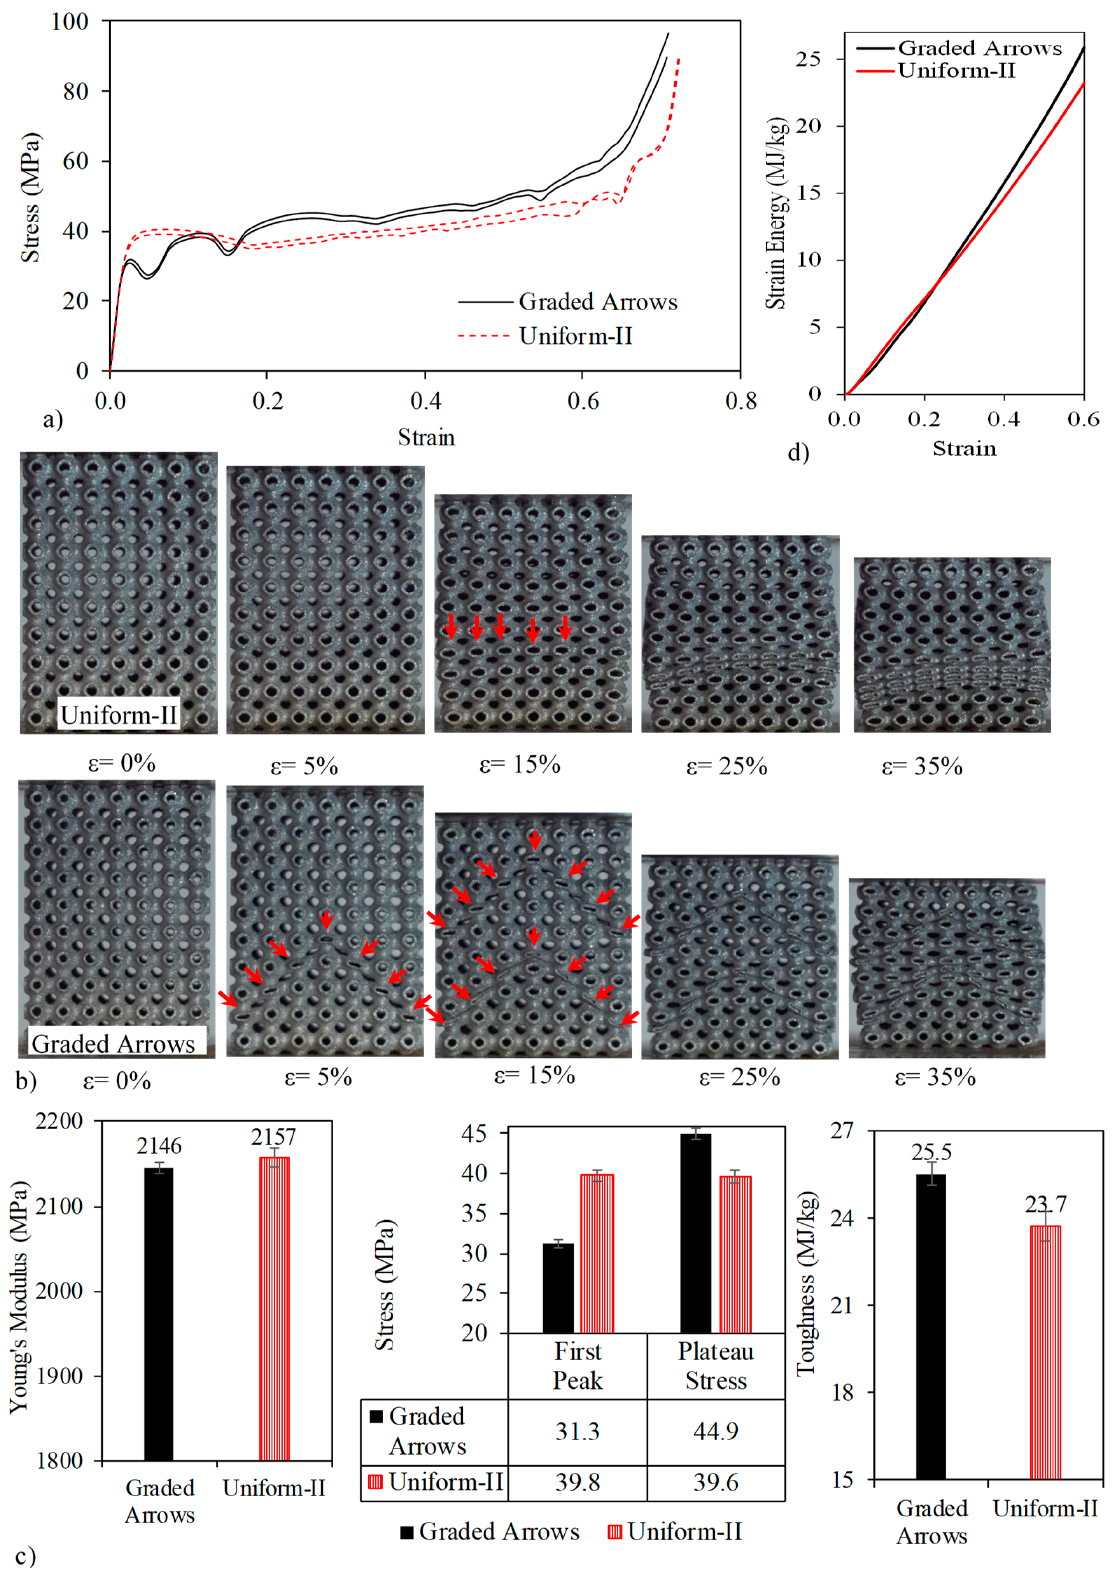
Figure 8. ( a ) Stress–strain response, ( b ) deformation pattern, ( c ) deduced mechanical properties of the graded arrow and uniform structures and ( d ) toughness as a function of strain level.